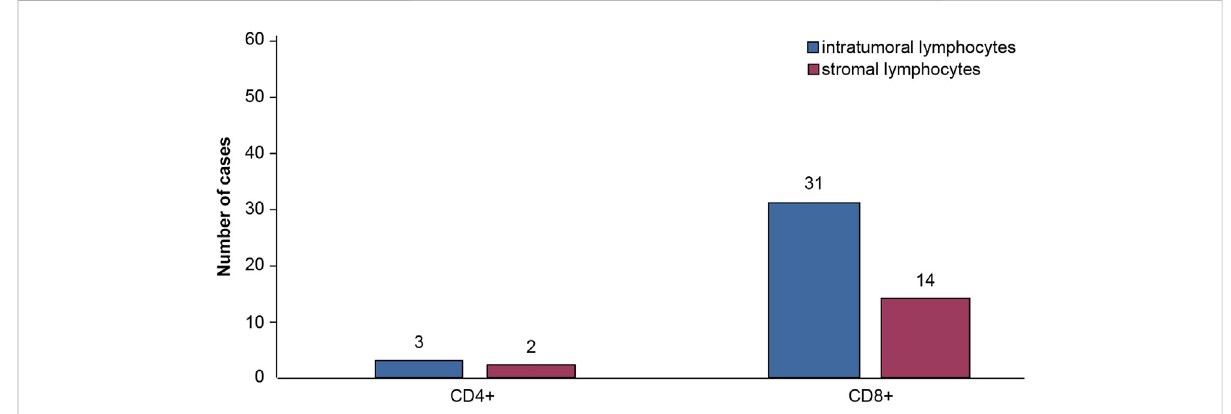
FIGURE 4 Numbers of positive cases of intratumoral and stromal CD4 + and CD8 + lymphocyte in fi ltration.